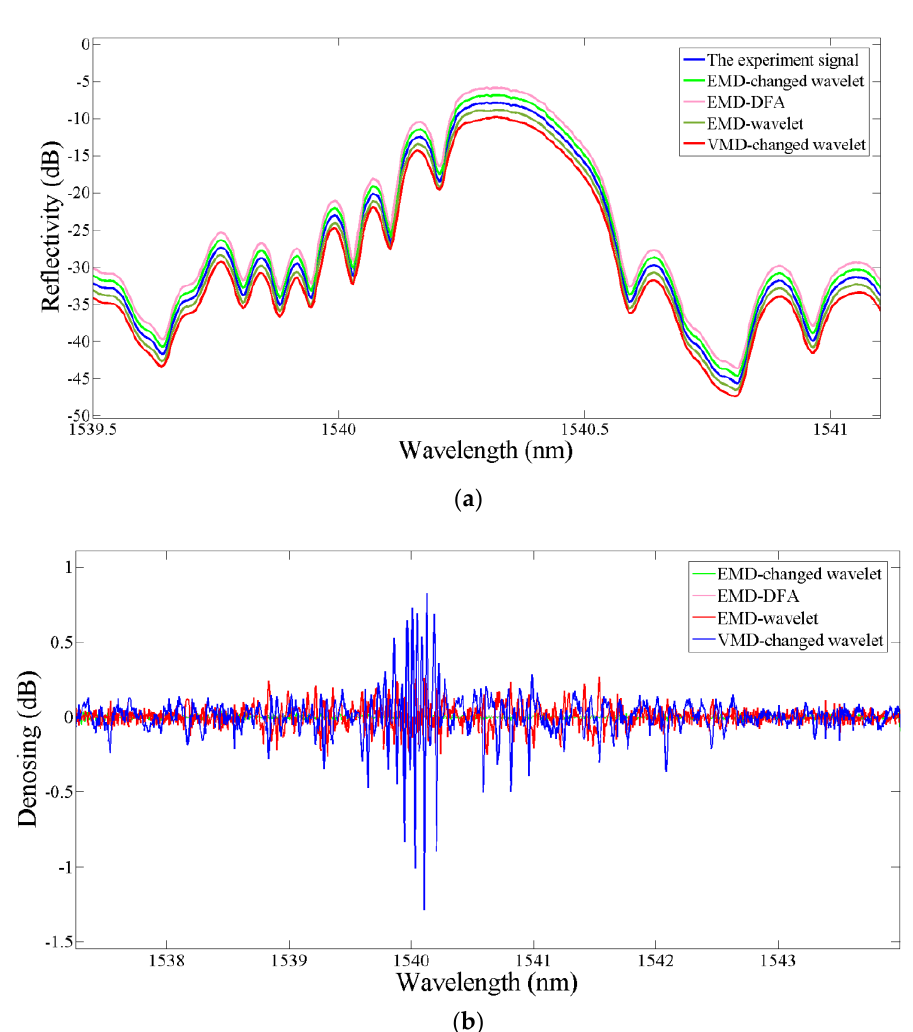
Figure 2. ( a ). FBG reflection spectrum with noise; ( b ) The de-noised spectrum signal of FBG by the proposed algorithm.